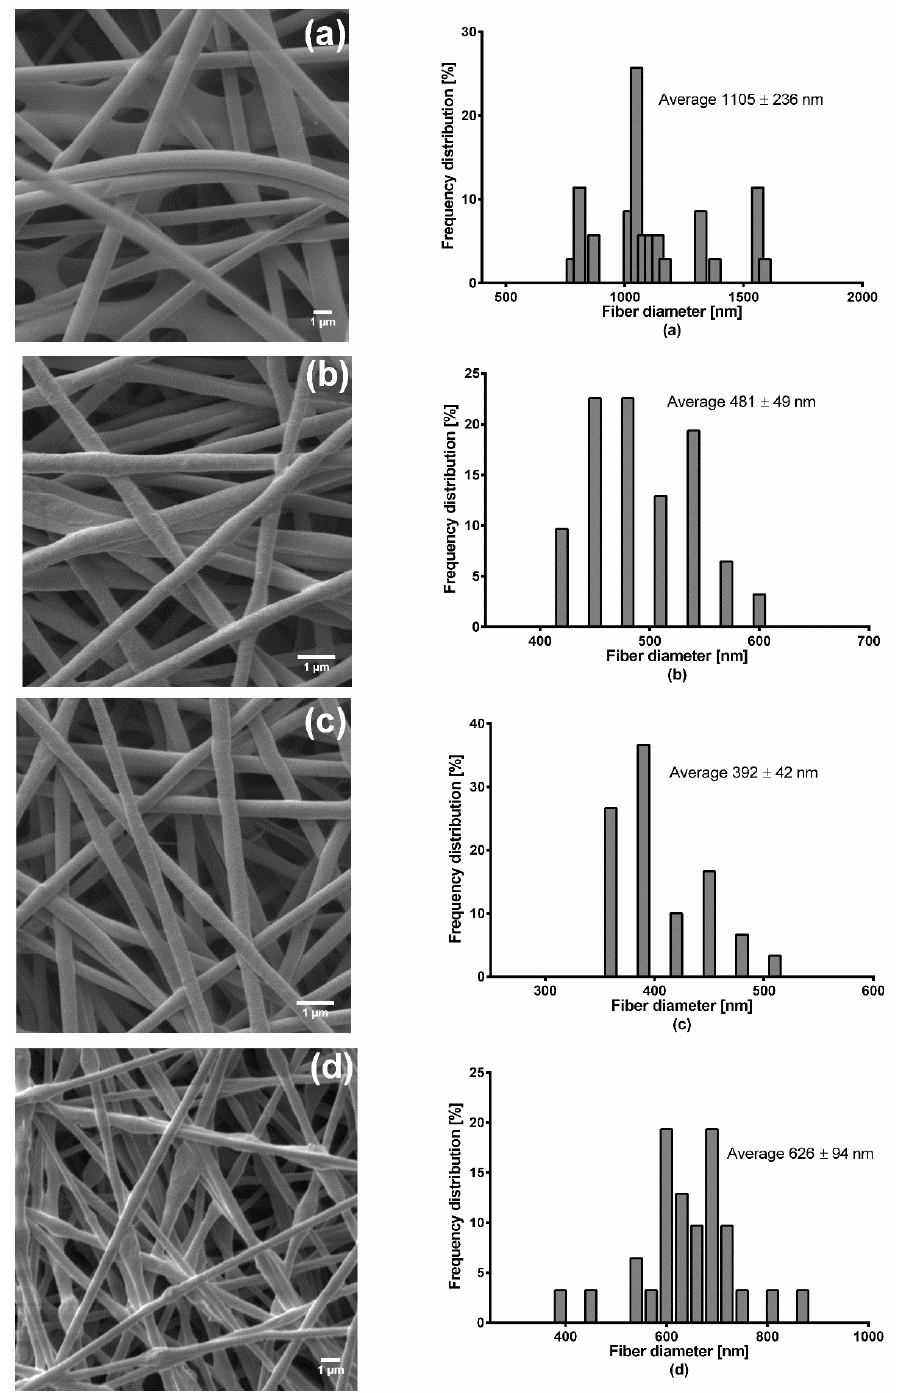
Figure 1. SEM micrographs and fiber diameter distribution of ( a ) pure PVA, ( b ) F1 ( c ) F2, and ( d ) F3 electrospun fiber mats.